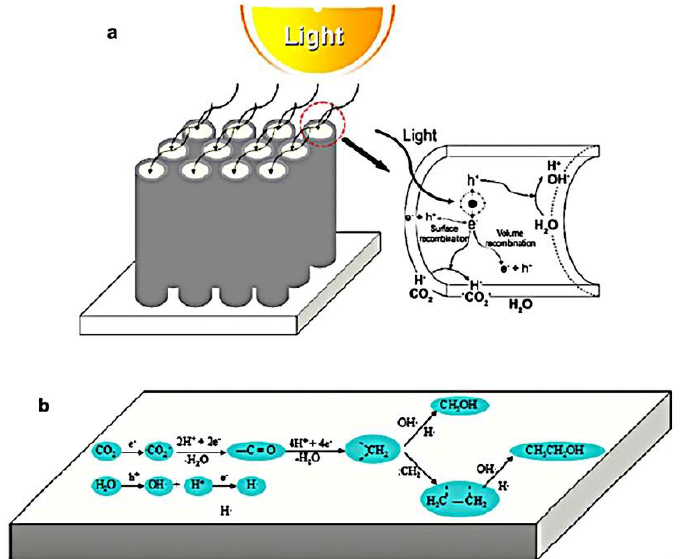
Figure 2. ( a ) Schematic illustration of the photocatalytic CO 2 reduction to alcohols over TiO 2 nano- tubes, and ( b ) proposed mechanism of photocatalytic CO 2 reduction to methanol and ethanol over TiO 2 nanotubes. Reproduced with permission from reference